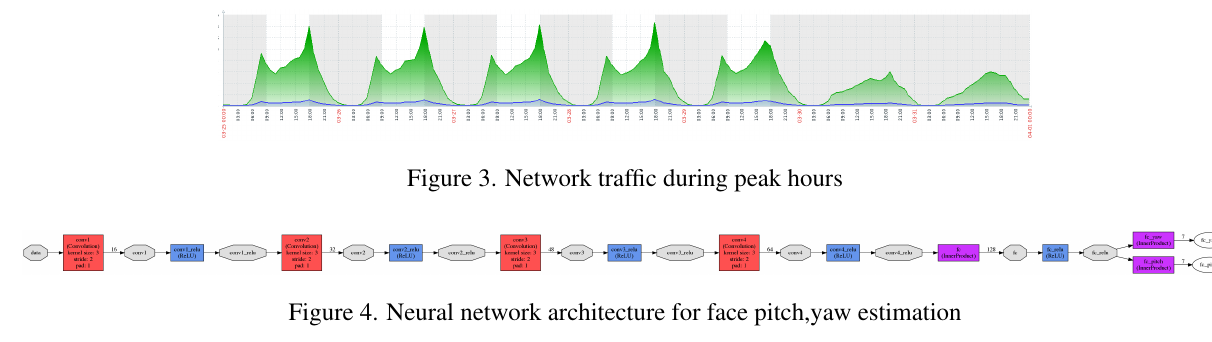
Figure 4. Neural network architecture for face pitch,yaw estimation